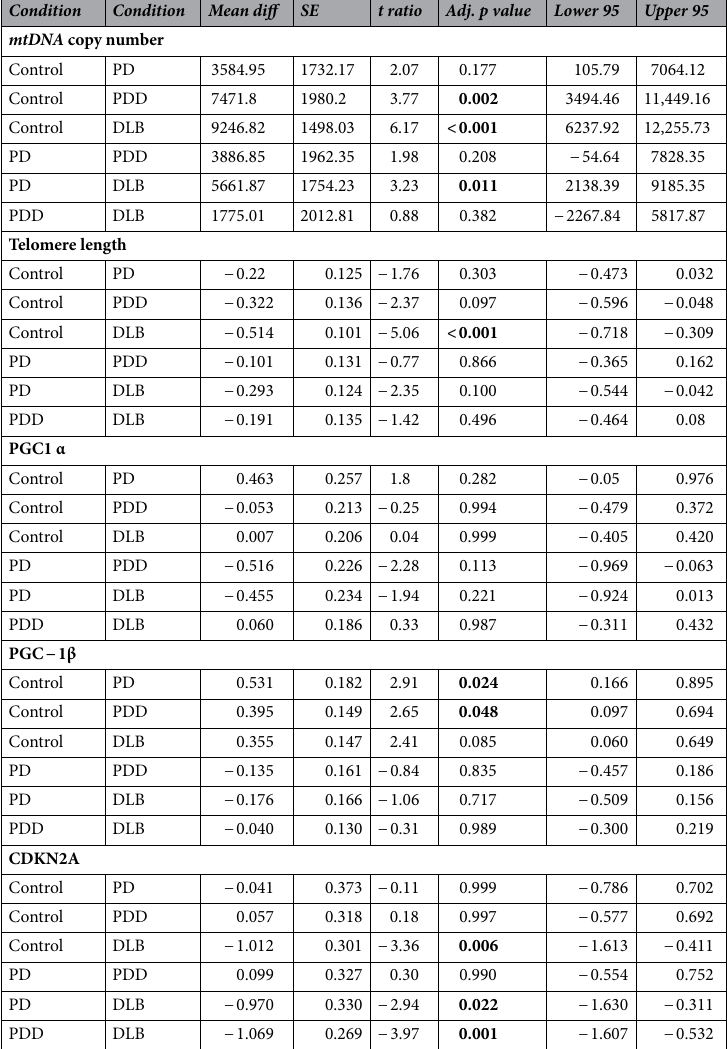
Table 1. Multi comparison (post hoc Tukey analysis) of mtDNA copy number, telomere length, PGC1a , PGC1b and CDKN2A between patient and controls in brain tissues. Significant are in value